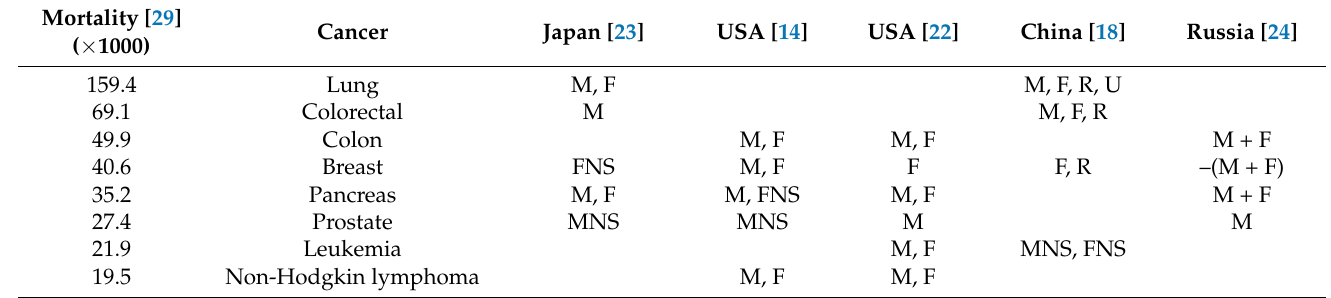
Table 3. Ecological studies of cancer mortality rates with respect to indices of solar UVB